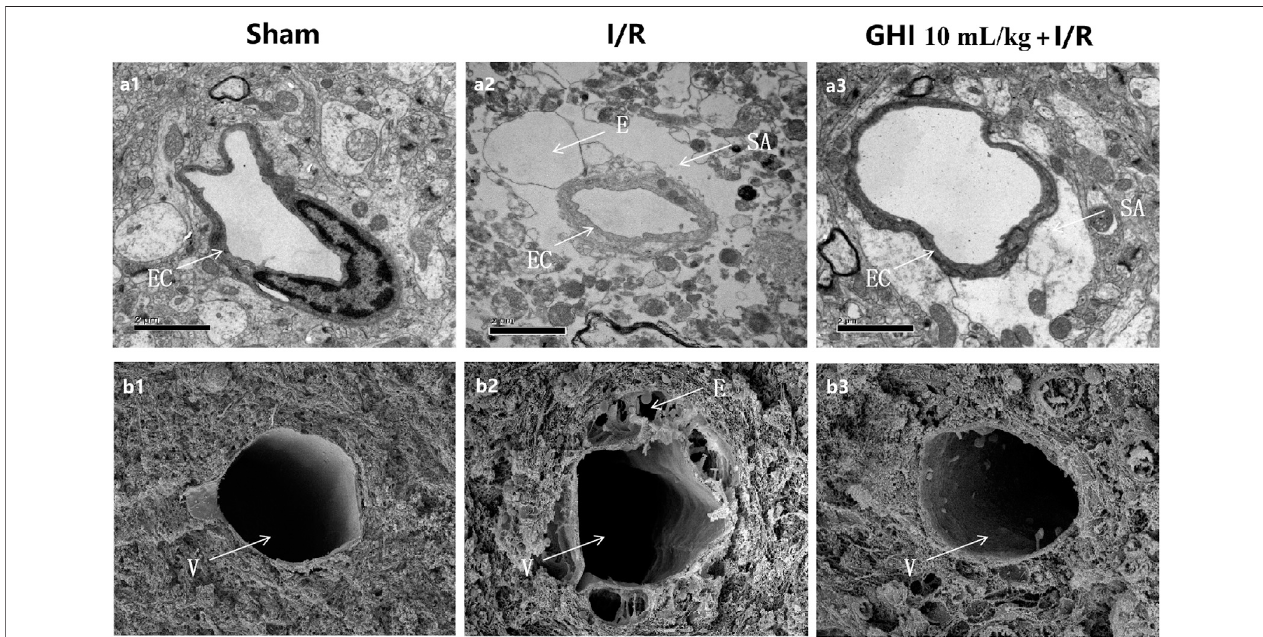
FIGURE4| Ultrastructureofmicrovesselsinthecerebralcortex.Thetransmissionelectronmicrographsofthecerebralcortexaredisplayedina1 – a3;thescanning electronmicrographsofthecerebralcortexaredisplayedinb1 – b3.a1,b1:Shamgroup;a2,b2:I/Rgroup;a3,b3:GHI10 ml/kg+I/Rgroup.E:perivascularedema;EC: endothelial cell; SA: swelling astroglial process; and V: venules (bar (cid:2) 50 μ m).